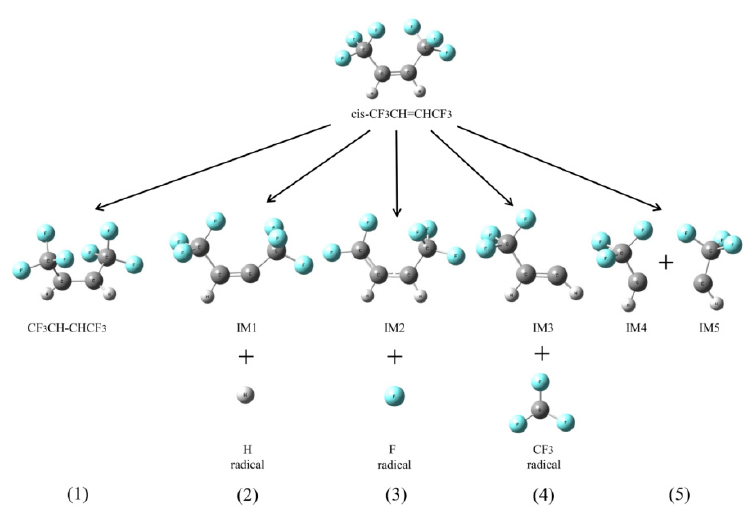
Figure 8. Main initiation reactions. C, H and F atoms are represented with black, gray and blue balls, respectively. Table 1. Bond distances and Bond Dissociation Energies (BDEs) of different kinds of bonds.